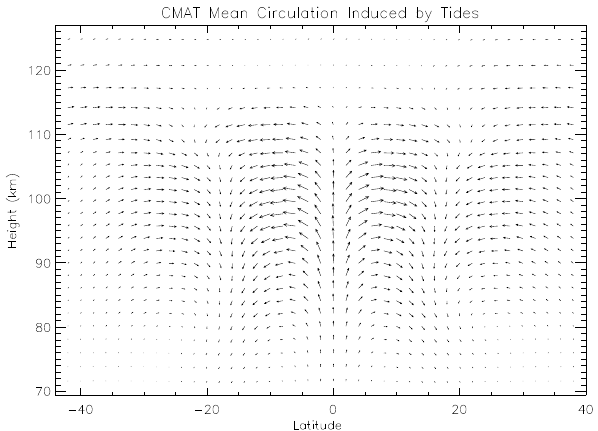
Fig. 11. Mean circulation induced with increased lower boundary tidal forcing as calculated by CMAT. The vertical winds have been scaled up by a factor of 80. Maximum vertical winds at the equa- tor in the 90–100km height region are about 3cm − s , and the maxi- mum meridional winds in the same height region at ± 10 ◦ are about 7.5ms − 1